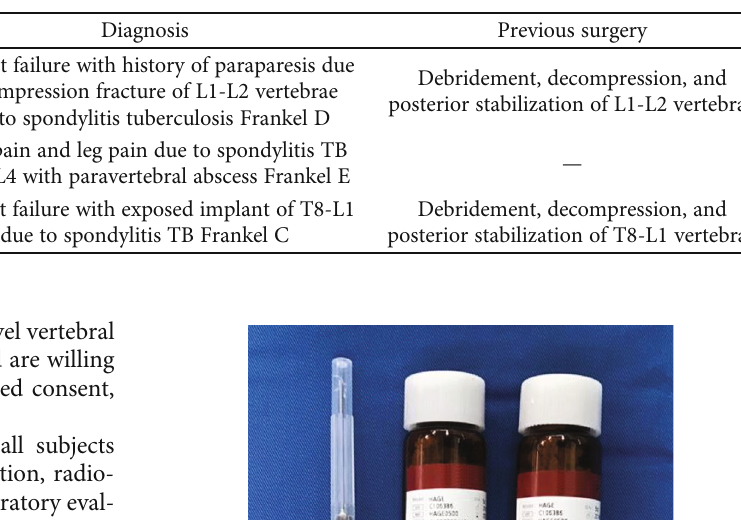
Table 1: Patient characteristics.